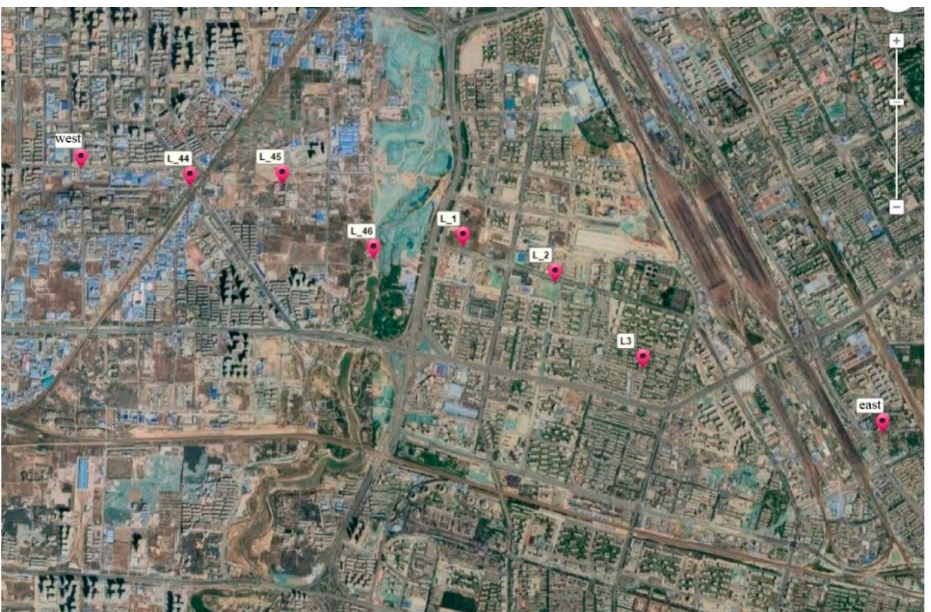
Figure 8. Ground Coverage of Test